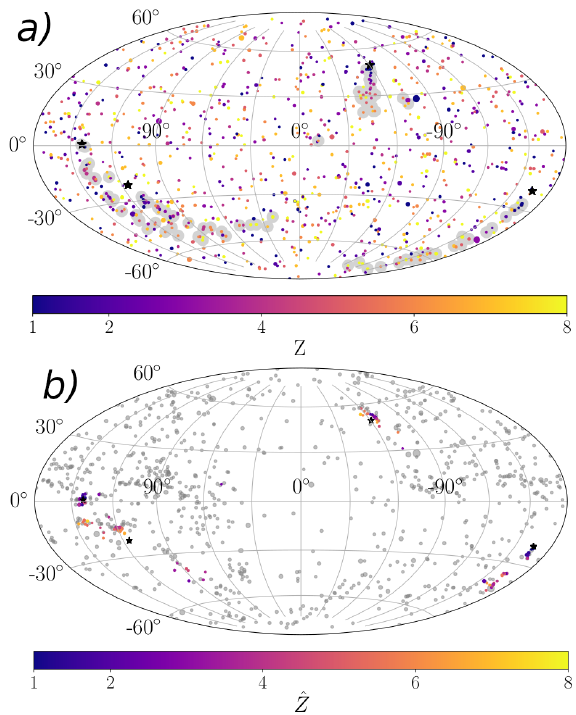
Figure 4. Skymaps in galactic coordinates showing a) the sim- ulated arrival scenario with signal cosmic rays denoted by gray background and b) fitted source directions ˆ s i with colored sym- bols referring to the signal events. The star symbols denote the source directions, the color code the charge of the cosmic rays, and the size is proportional to the energy of the cosmic